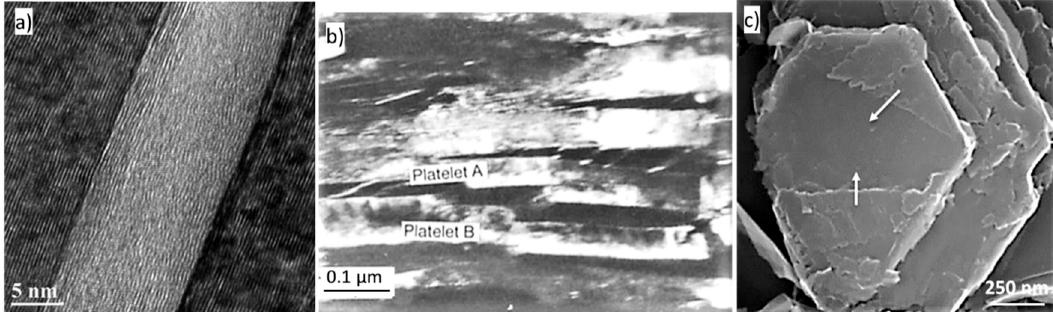
Figure 6. Images of graphite platelets in graphite of various origins: ( a ) HR-TEM image of the 002 fringes of a graphite platelet in a graphite spheroid from carbon-steel, reproduced from [28] with permission from Elsevier; ( b ) TEM dark field image of platelets in a graphite spherulite, reproduced from [29] with permission from Springer; ( c ) SEM image of growth front of new layers on platelets in a compacted graphite iron sample, reproduced from [30] with permission from Elsevier.